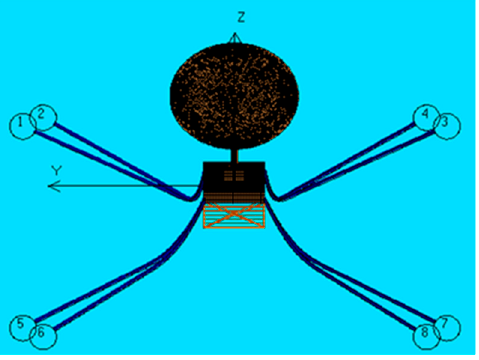
Figure 6. Diagram of the wind speed-thrust curve.